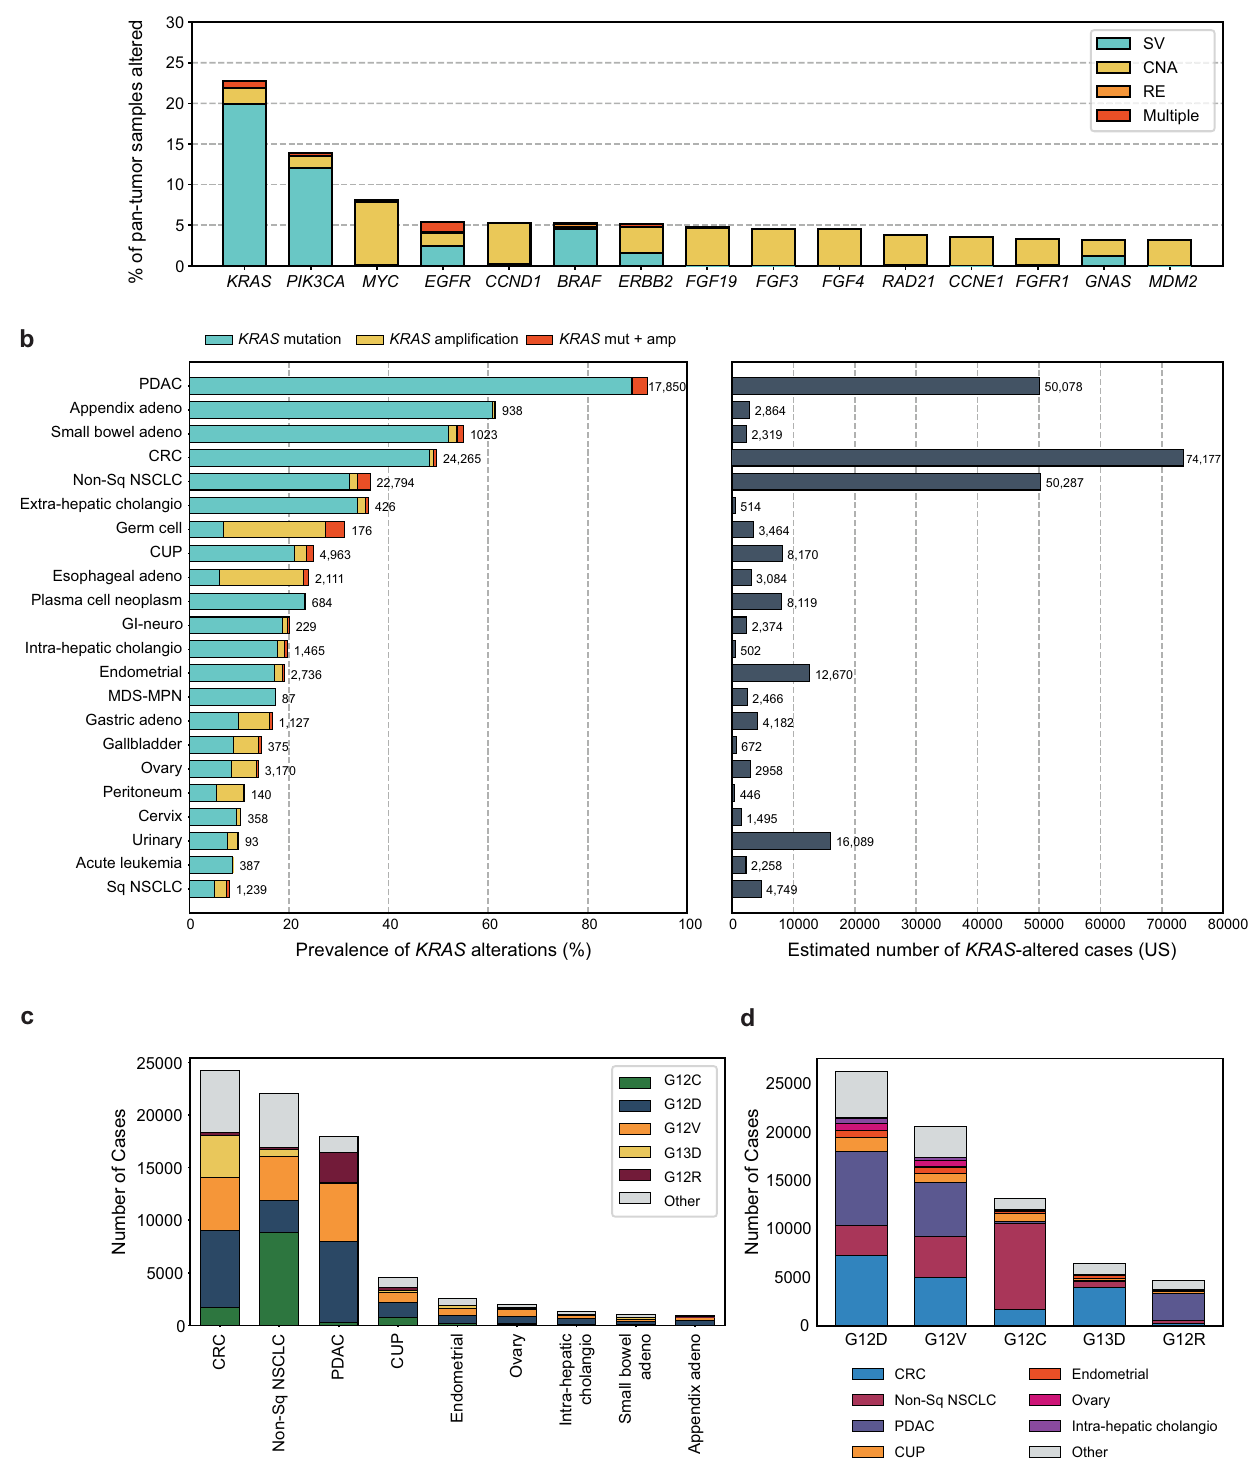
Fig. 1 Prevalence of KRAS alterations among adult patients with cancer. a In the Foundation Medicine (FM) dataset of tissue or hematologic samples from 426,706 adult patients with cancer, KRAS was the most frequently altered oncogene with alterations in 23% of samples. A longtail of other top frequently altered oncogenes is shown; bar colors indicate alteration classes, SV: short variant mutation (e.g., substitutions, indels), CNA: copy number alteration, RE: rearrangement. b Prevalence in the FM dataset (left) and incidence estimates in the United States (right) of KRAS alterations in common adult tumor types (Supplemental Table 1). KRAS alterations are most prevalent in PDAC, appendix adenocarcinoma, small bowel and CRC tumor types. The highest incidence of KRAS alterations is estimated in CRC, non-Sq NSCLC and PDAC. c , d Number of cases in the FM database with KRAS mutations among ( c ) the 8 top indications with highest incidence of KRAS alterations and carcinoma of unknown primary (CUP) and d the 5 most common KRAS mutant